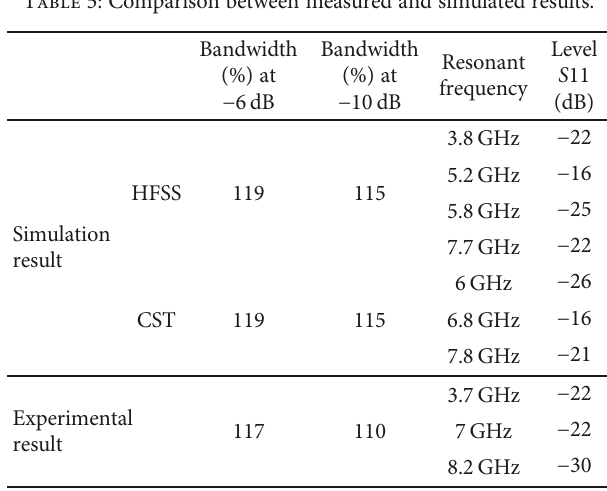
Figure 14: Dimensions presentation of the realized UWB array antennas. (a) Length of array antennas. (b) Width of array antennas. Table 5: Comparison between measured and simulated